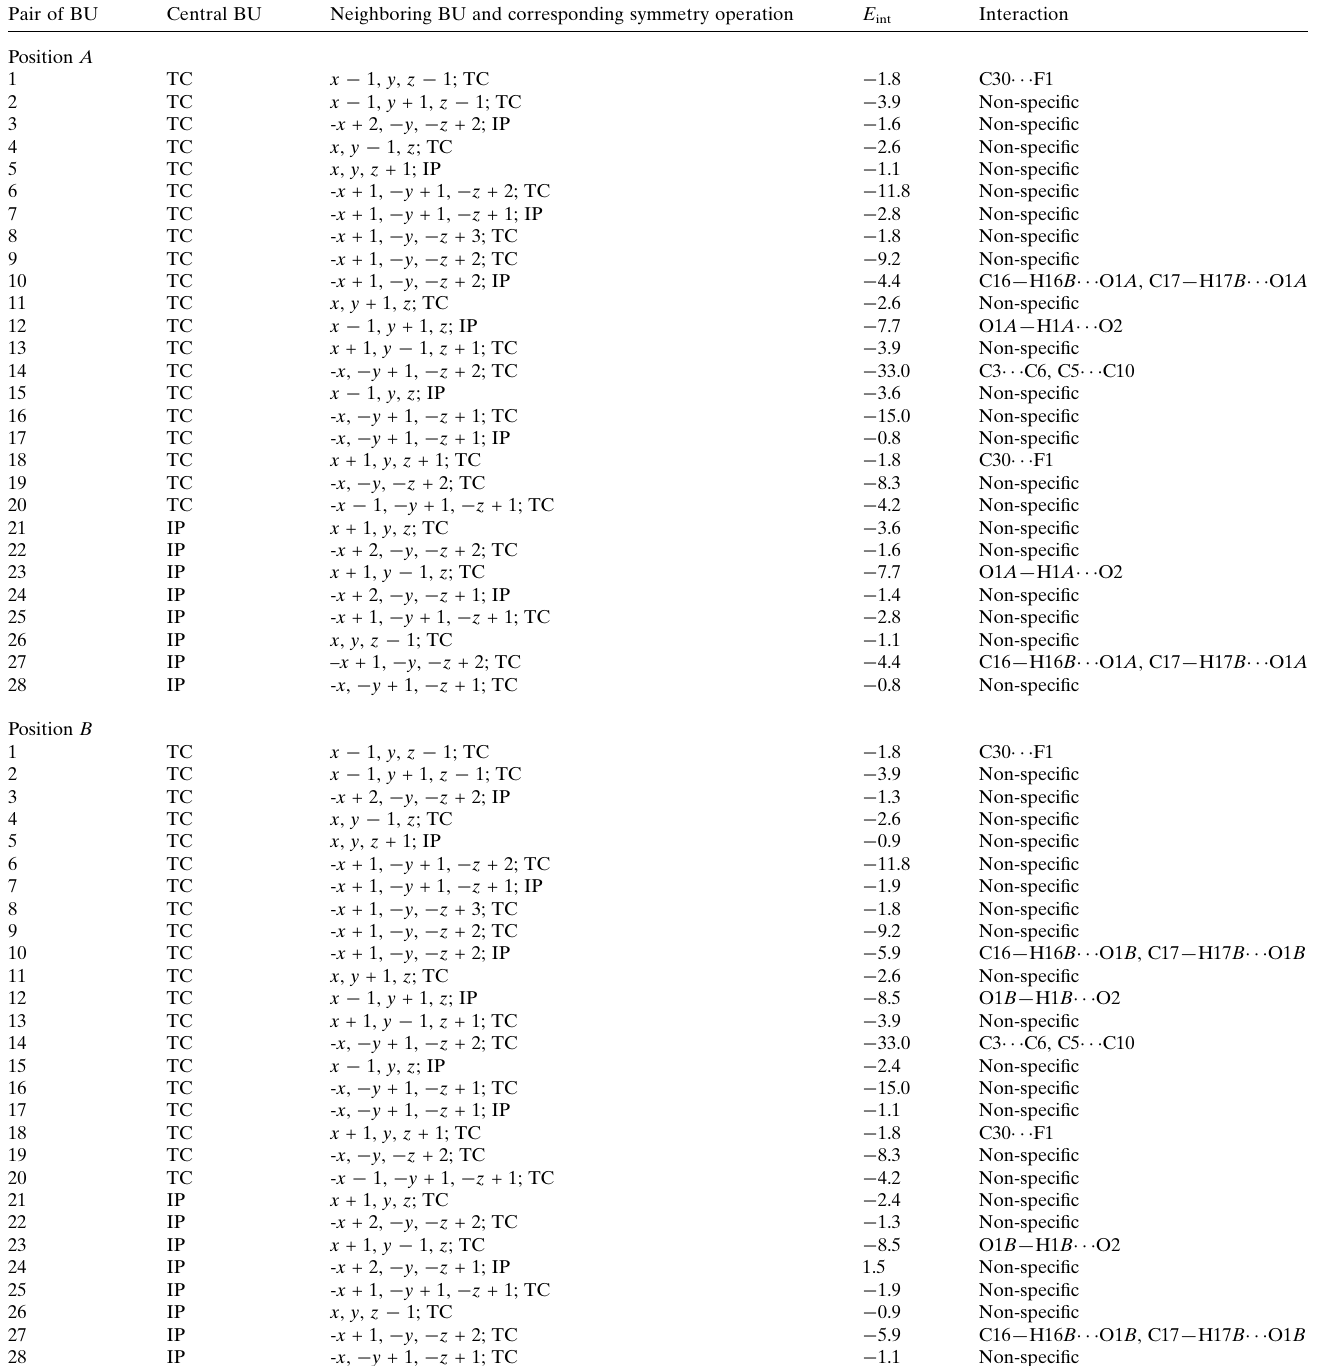
Table 2 Symmetry codes, binding types and interaction energies (kcal mol (cid:4) 1 ) of the building units (BU) (single molecules) with neighbors. Pair of BU Central BU Neighboring BU and corresponding symmetry